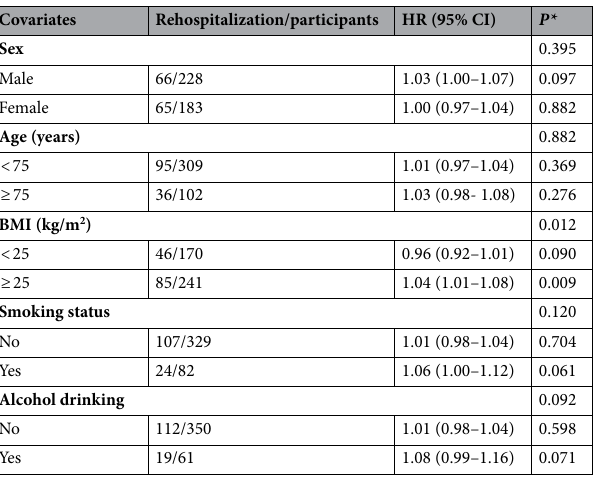
Table 5. Subgroup analyses for associations between serum selenium and the risk of rehospitalization in patients with heart failure. *Adjusted for age, sex (except in the sex-stratified analysis), body mass index, smoking (except in the smoking-stratified analysis), drinking (except in the alcohol-stratified analysis), hypertension, diabetes, chronic kidney disease, prior history of heart failure, atrial fibrillation and medication.